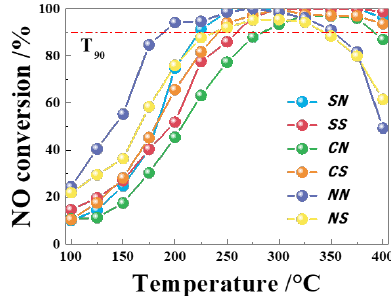
Figure 1. Catalytic performance of titanium modified FeMgO x catalysts with different precursors.